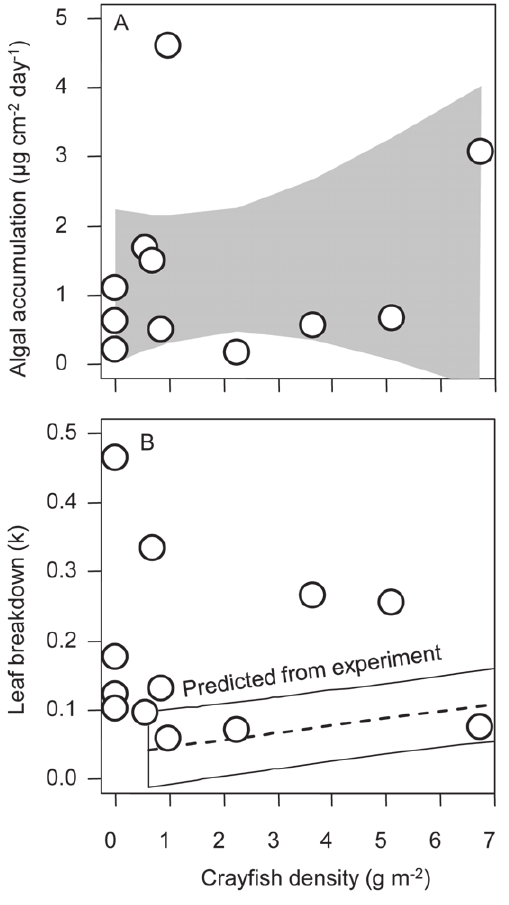
Figure 5. Consumption of leaf litter by three detritivores: the invasive signal crayfish ( P.leniusculus ), and the native caddis- flies Lepidostomaspp . and Psychoglypha spp. (order: Tricoptera) in feeding trials. Individual mass is dry mass of the individual after the experiment. Consumption is the amount of leaves eaten, normalized by background loss rate (see Methods). Also shown is the best fit allometric relationship.